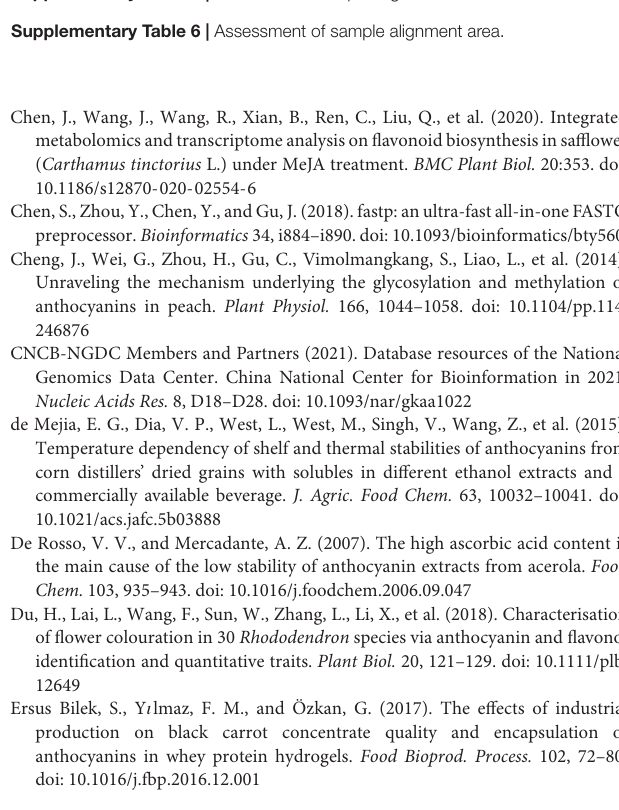
represents a higher similarity. (B) Venn analysis among CK vs T1, CK vs T2, CK vs T3, and CK vs T4. (C) Number of DEGs among all comparison units. Supplementary Figure 2 | The GO and KEGG enrichment results of overlapping DEGs (634 DEGs). (A) GO enrichment results of overlapping DEGs. (B) The enrichment results of the top 15 KEGG pathways according to the p value. Red presents significant enrichment. Supplementary Figure 3 | The identification results of TFs related to anthocyanin accumulation. (A) The number and type of TFs and differentially expressed TFs. (B) The heatmap analysis of TFs involved in anthocyanin accumulation according to FPKM value. The red represents high expression level, while blue represents low expression level. Supplementary Figure 4 | The expression level of DEGs in different modules. (A) The expression trend of genes in brown module among all samples. (B) The expression trend of genes in turquoise module among all samples. (C) The expression trend of genes in yellow module among all samples. Supplementary Figure 5 | qRT-PCR validation of gene expression level in the transcriptome. The color of columns represents different samples. The height of column represents qRT-PCR results of genes (2 − (cid:49) (cid:49) Ct ), while the line represents FPKM value of genes. Supplementary Figure 6 | Correlation analysis of the results between RNA-seq and qRT-PCR. The qRT-PCR (2 − (cid:49) (cid:49) Ct ) and RNA-seq results were normalized by log 2 . Supplementary Table 1 | Primers used in qRT-PCR. Supplementary Table 2 | The classification and quantification results of all detected metabolites. Supplementary Table 3 | Summary of sequencing data. Supplementary Table 4 | Detection of sample alignment rate. Supplementary Table 5 | Evaluation of sample alignment area. Supplementary Table 6 | Assessment of sample alignment